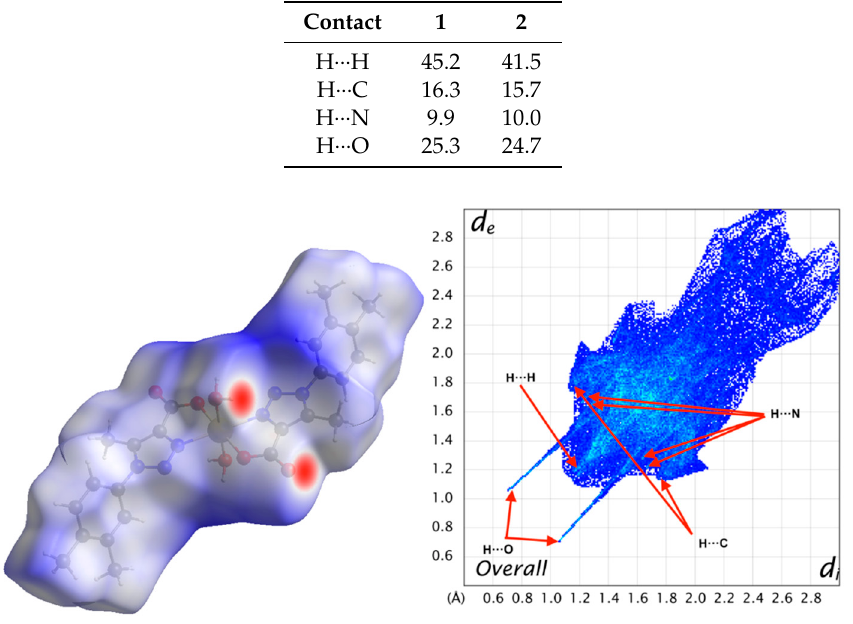
Figure 4. d norm surface for the ZnL 2 (H 2 O) 2 complex (left) and its 2D fingerprint plot (right). In the left panel, red and blue colors indicate strong and weak interactions, respectively. Isovalues range from − 0.66 (blue) to +2.31 (red).